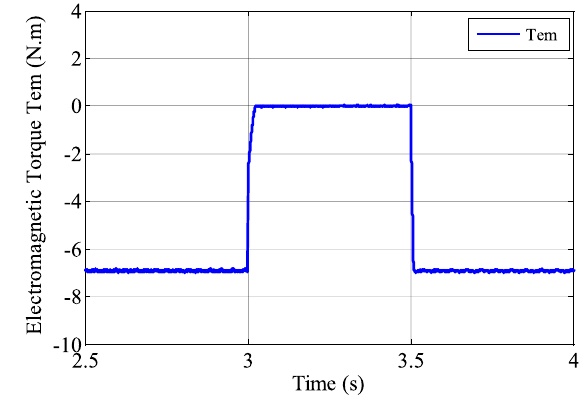
Fig. 13 Active Stator Power Error e 1